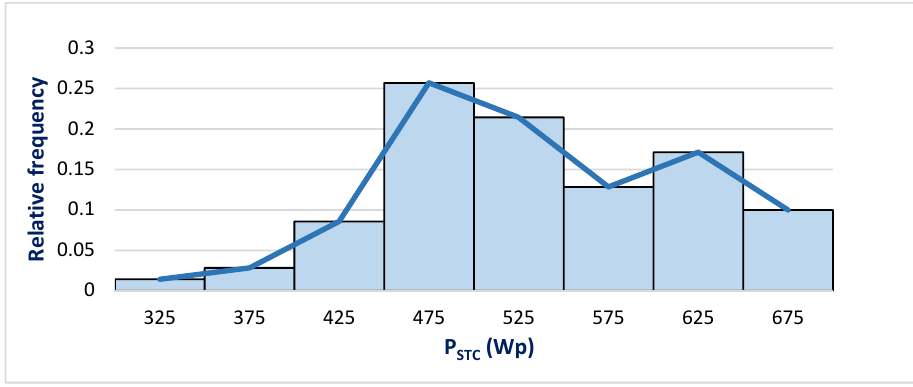
Figure 9. Histogram of the index P STC . Similarly, the indicator P NOCT (Wp) is related to the characterization of the modules used in the design of PV plants. Specifically, it represents the peak power of the modules under NOCT conditions. Figure 10 shows that the variability of this indicator is much lower than that of P STC , varying between 250 and 550 Wp, and it can also be seen that the distribution is more homogeneous since, except for the values between 500 and 550 Wp, where a single case is registered, for the remaining classes, the relative frequency is between